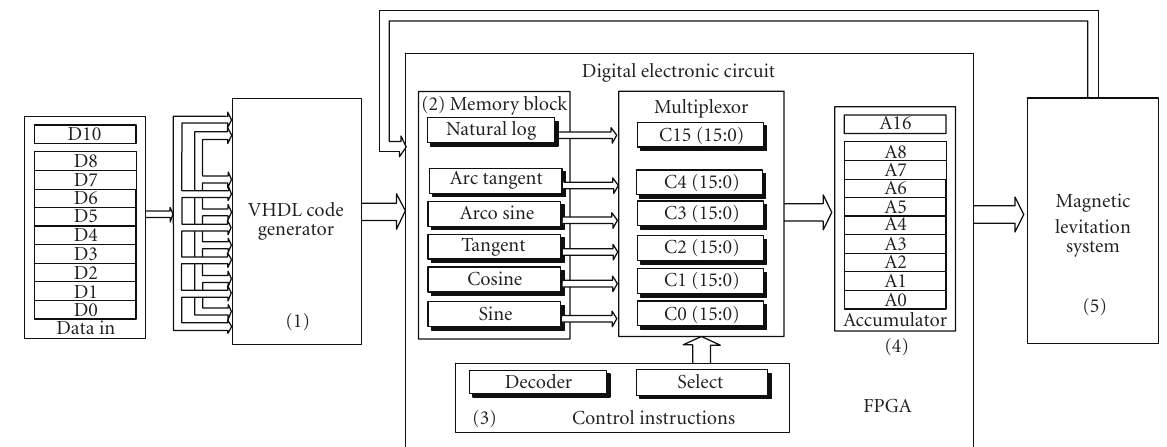
Figure 1: Block diagram of the FPGA